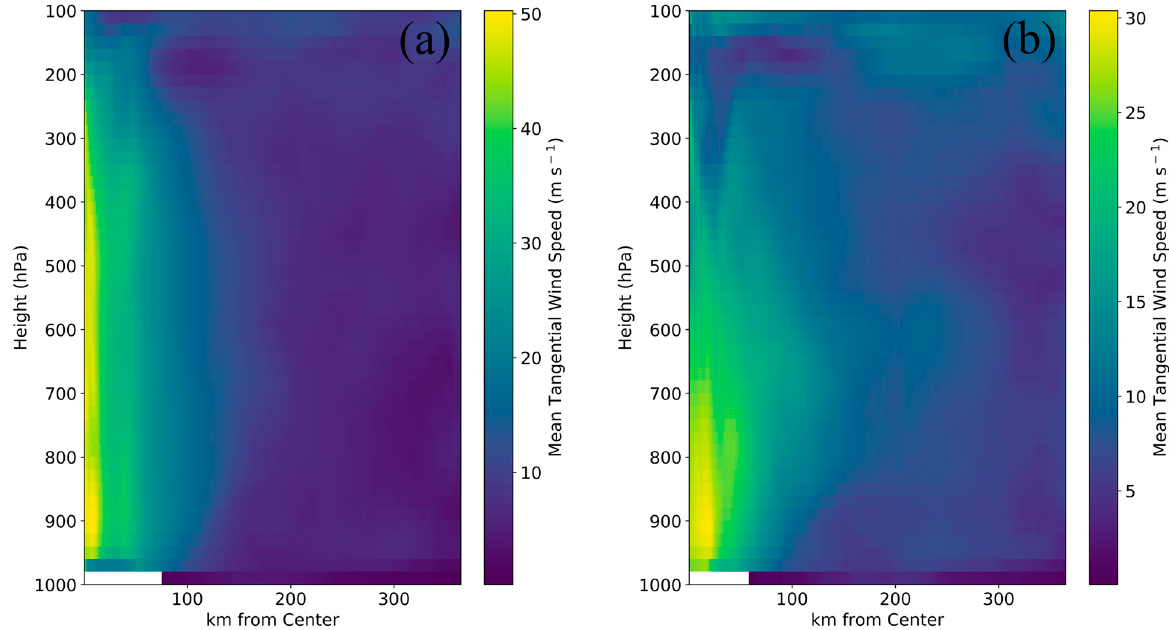
Figure 9. Radial–height cross-sections of azimuthally averaged tangential winds at 0000 UTC on 2 October 2021 by ( a ) YSU and ( b ) ACM2 schemes.